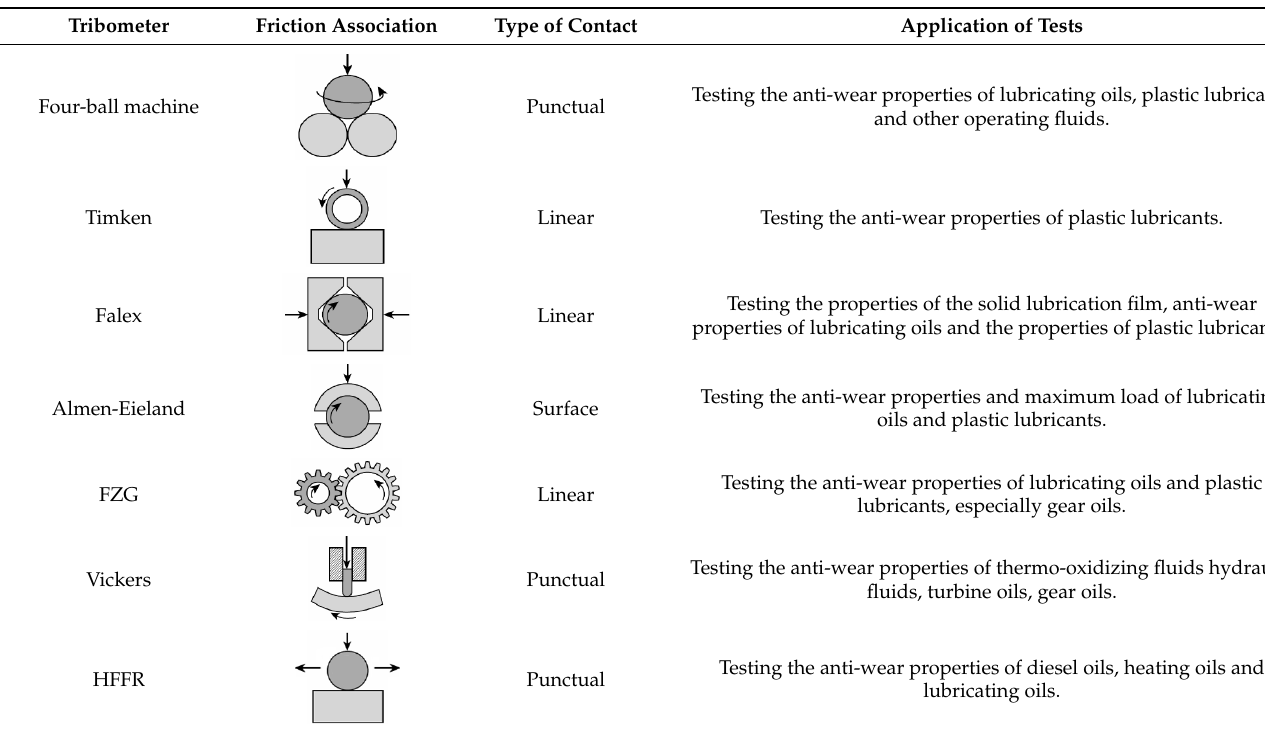
Testing the properties of the solid lubrication film, anti-wear properties of lubricating oils and the properties of plastic